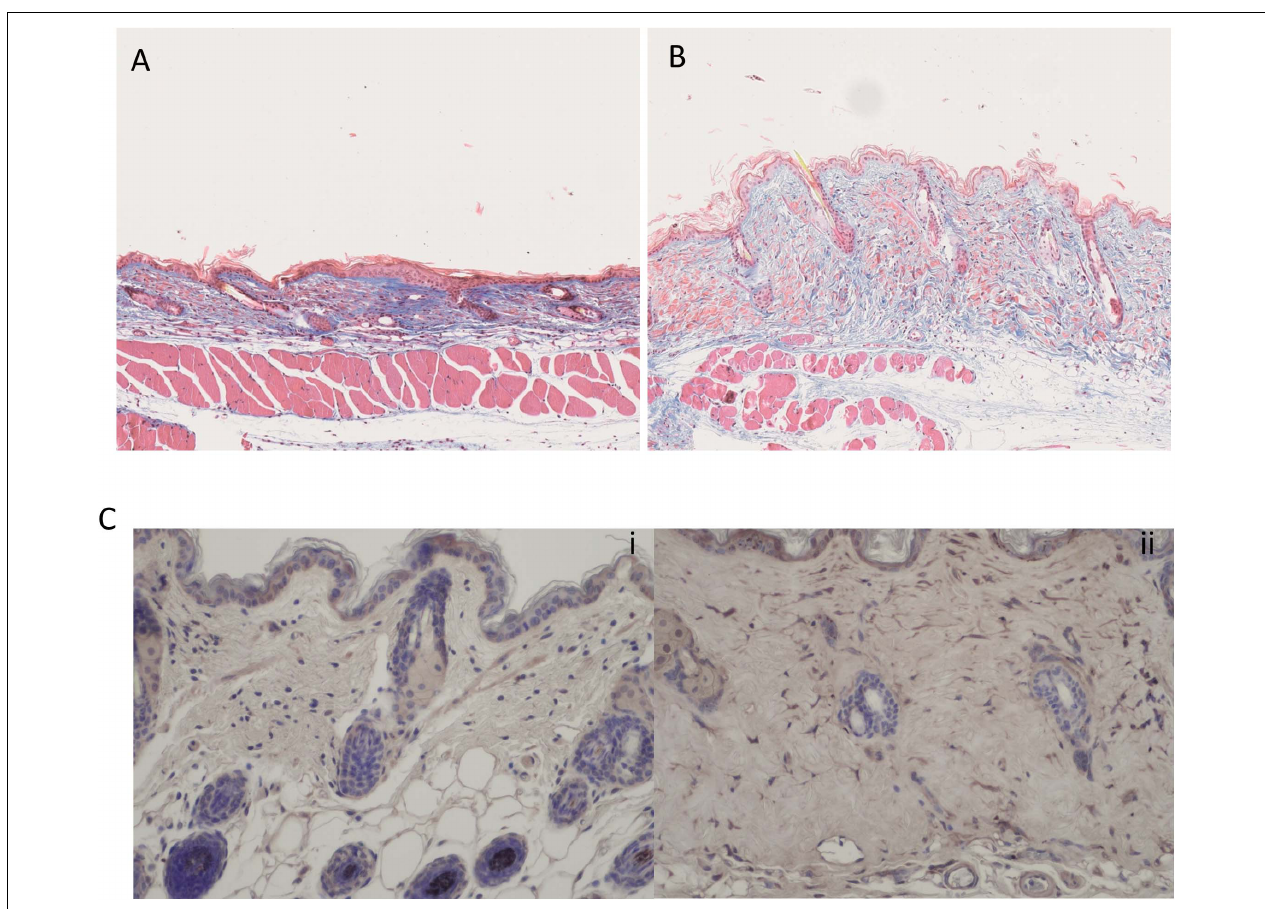
FIGURE 9 | Bleomycin treated mice have elevated skin fibrosis and Gremlin-1 expression. (A) Representative Trichrome staining of NaCl treated mice. (B) Representative Trichrome staining of bleomycin treated mice- showing excessive skin thickening. Magnification × 10. (C) Immunohistochemistry of Gremlin-1 using specific antibody to Gremlin-1 (i) NaCl treated mice and (ii) bleomycin treated mice. Hematoxylin is the nuclear stain. Magnification ×